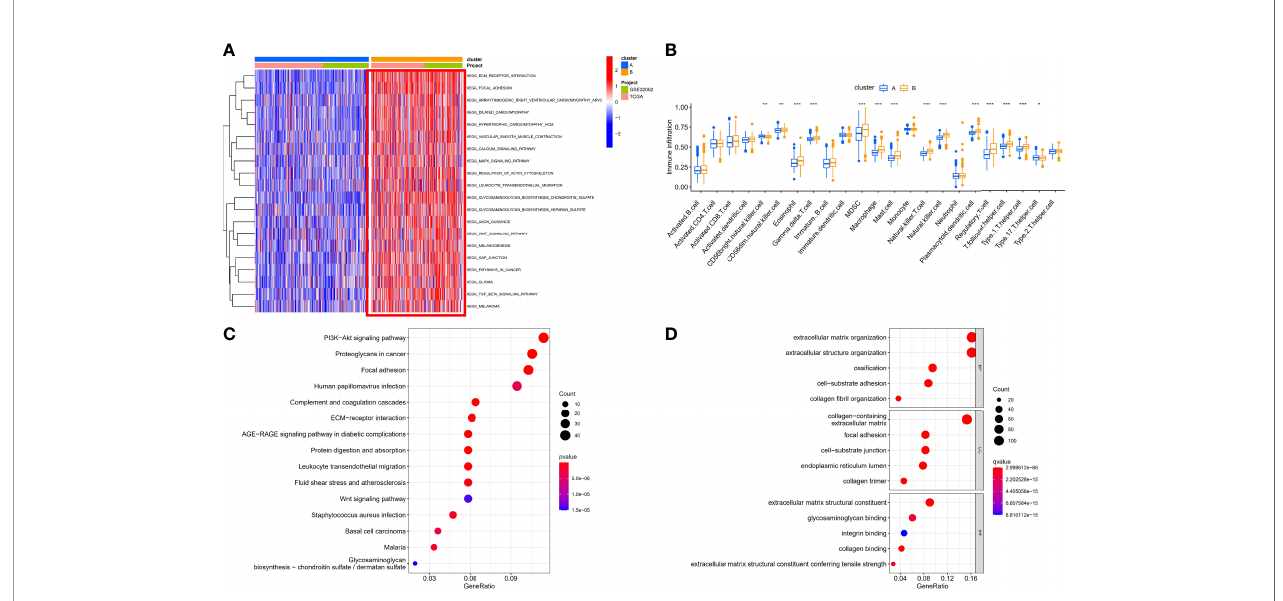
FIGURE 4 | The immunological and biological characteristics in different hypoxia patterns. (A) GSVA analysis in different hypoxia patterns using kegg.v7.4 gene sets. (B) Box plot of immune cells in different hypoxia patterns. (C) Bubble plot of KEGG enrichment analysis. (D) Bubble plot of GO enrichment analysis. *p < 0.05, **p < 0.01, ***p <